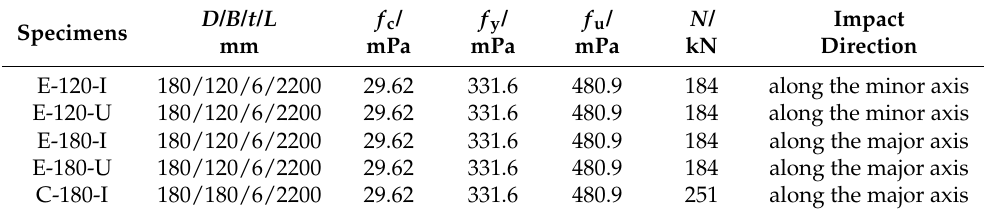
Table 1. Parameters of the tested specimens.